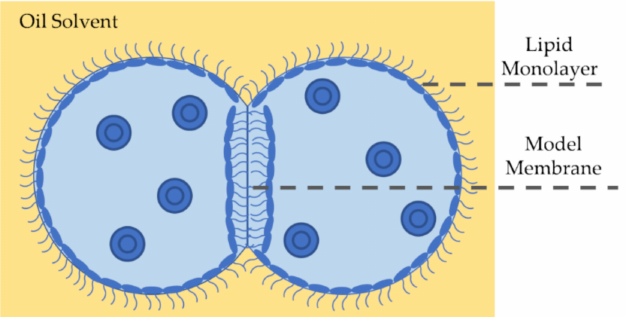
Figure 6. A DIB is a model membrane formed at the interface of two lipid-coated droplets in oil. Submerging lipid-dispersed aqueous droplets in an oil medium leads to the self-assembly of the amphiphilic molecules at the water-oil interface forming the monolayers. Note that it is possible to have the phospholipids dispersed in oil or water. Placing the droplets into contact, the membrane spontaneously forms at their adhered interface. The droplets contact angle links the membrane mechanics to the DIB’s equilibrium state is dictated by the balance of surface